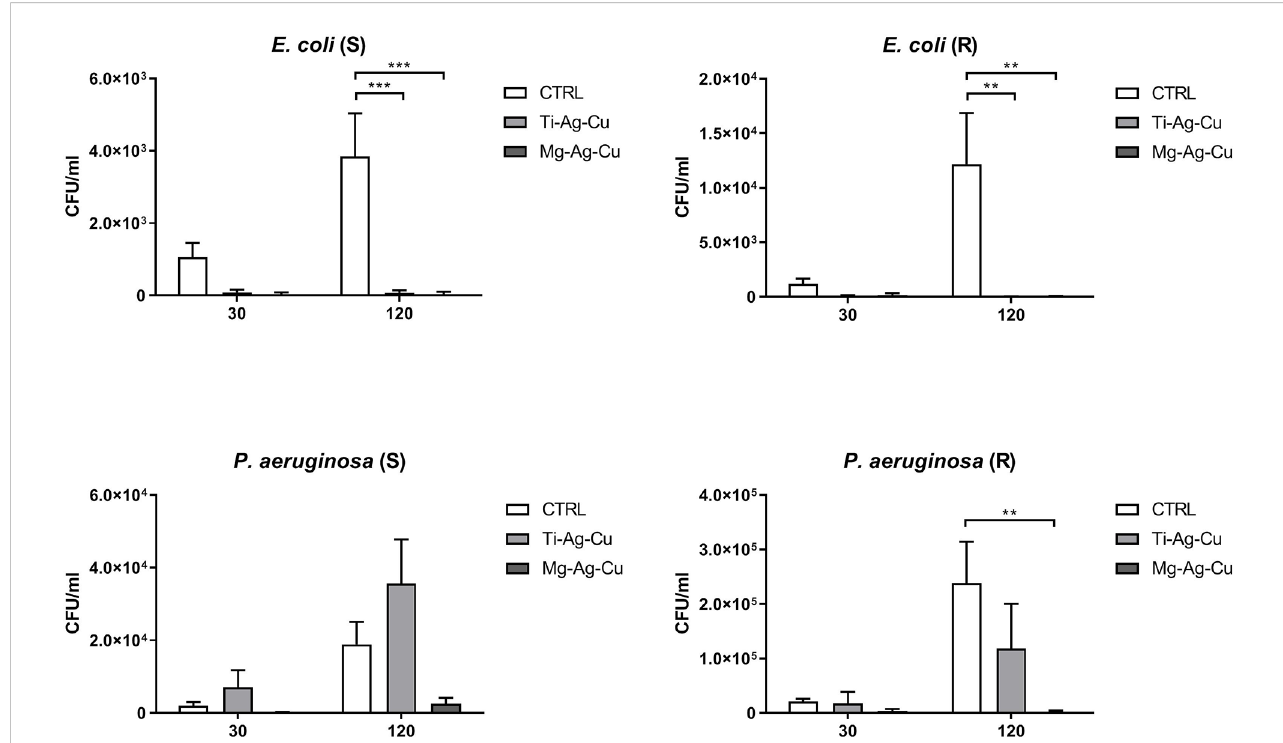
FIGURE 4 Adhesion of E. coli and P. aeruginosa on the surface of Ti-Ag-Cu and Mg-Ag-Cu-coated discs and uncoated glass surface (CTRL) after 30 and 120 minutes of incubation. Statistical signi fi cance: p < 0.01 (**) and p < 0.001